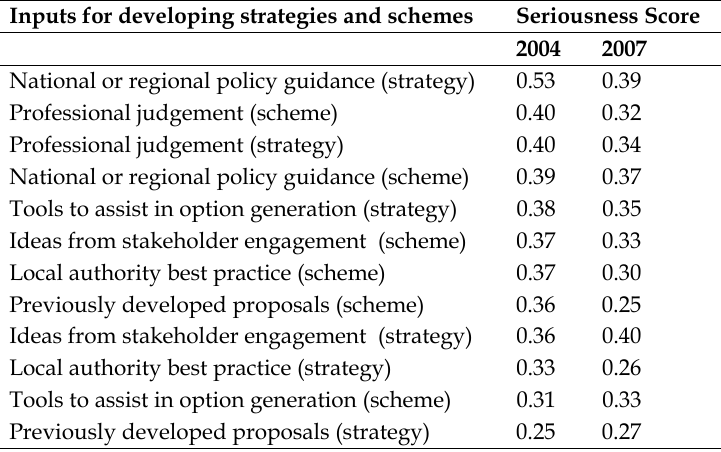
Table 3. Inputs into strategy and scheme option